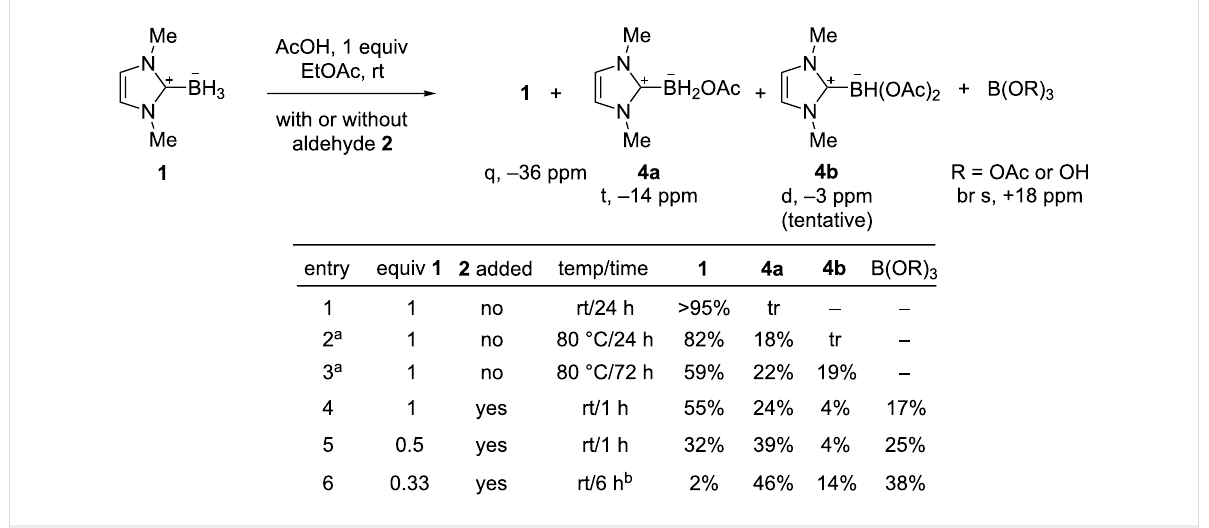
Figure 1: 11 B NMR studies of boron products from 1 and acetic acid with and without aldehyde 2 . a In C 6 D 6 ; b unreacted aldehyde remained.